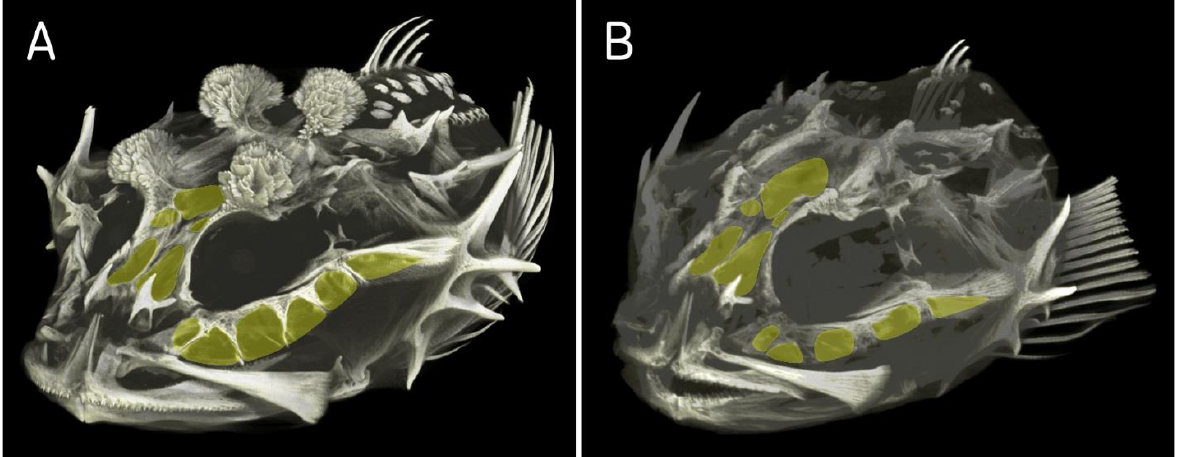
Figure 5. The tomograms of the cranium of fourhorn sculpins: ( A ) T. quadricornis , ZIN 26934, Baltic Sea; ( B ) Triglopsis sp., ZIN 56884, White Sea.